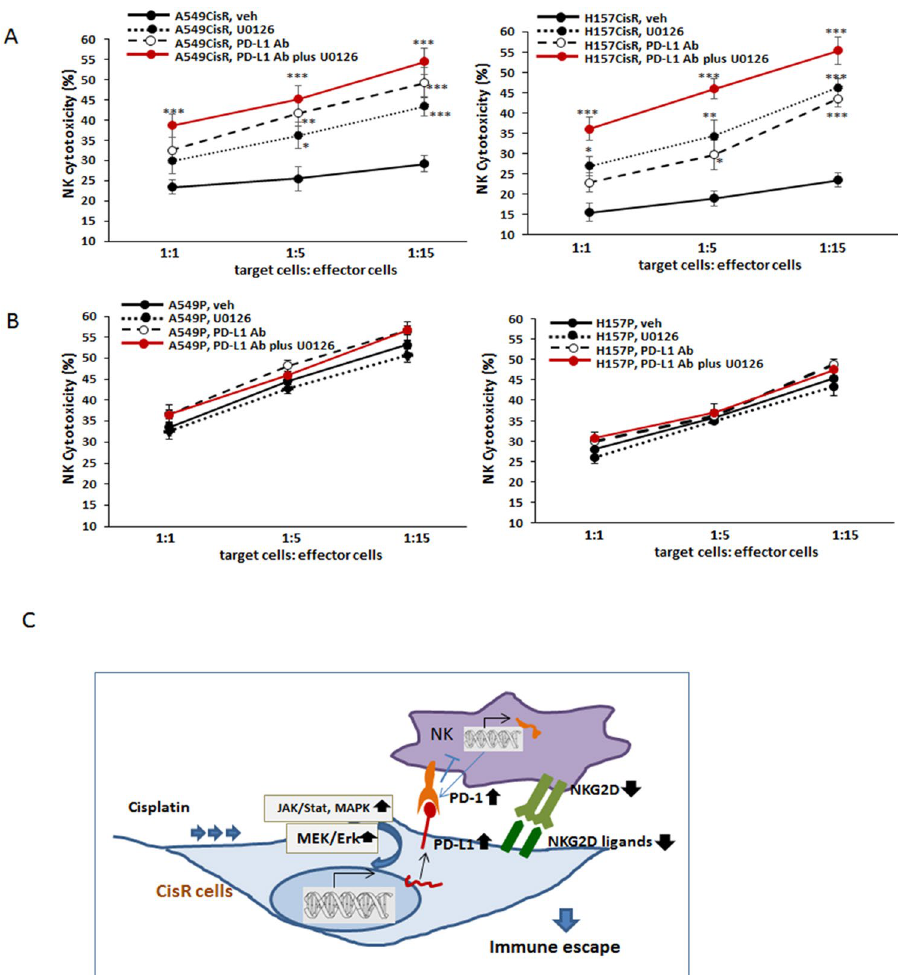
Figure 6. Combined effects of inhibitor of MEK/Erk signaling pathway and PD-L1 Ab on NK cytotoxicity. The susceptibility of cisplatin-resistant lung cancer cells to cytotoxic action of primary NK cells was enhanced when the inhibitor of MEK/Erk signaling pathway and PD-L1 Ab were both present. ( A , B ) ( A ) NK cytotoxicity tests (primary NK cells) of A549CisR and H157CisR cells. ( B ) A549P and H157P cells in the presence of PD-L1Ab alone, U0126 alone, vs. both present in the co-culture of tumor cells/primary NK cells. ( C) A cartoon depicting tumor cell and NK cell interactions through PD-L1/PD-1 and NKG2D ligands/NKG2D axis. * p < 0.05, ** p < 0.01, *** p <